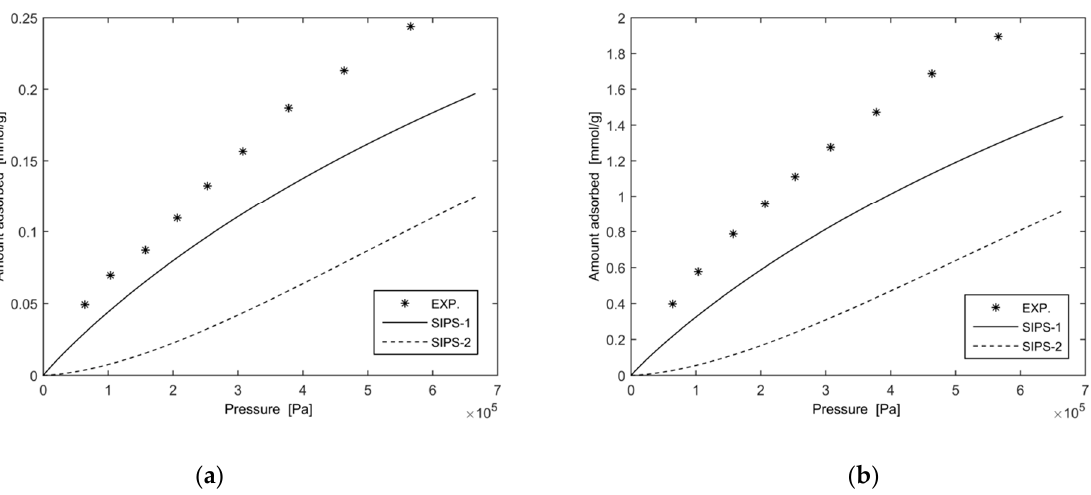
Figure 1. Adsorption results for ( a ) nitrogen and ( b ) methane gases, as experimentally observed and as modelled by the Sips equations.